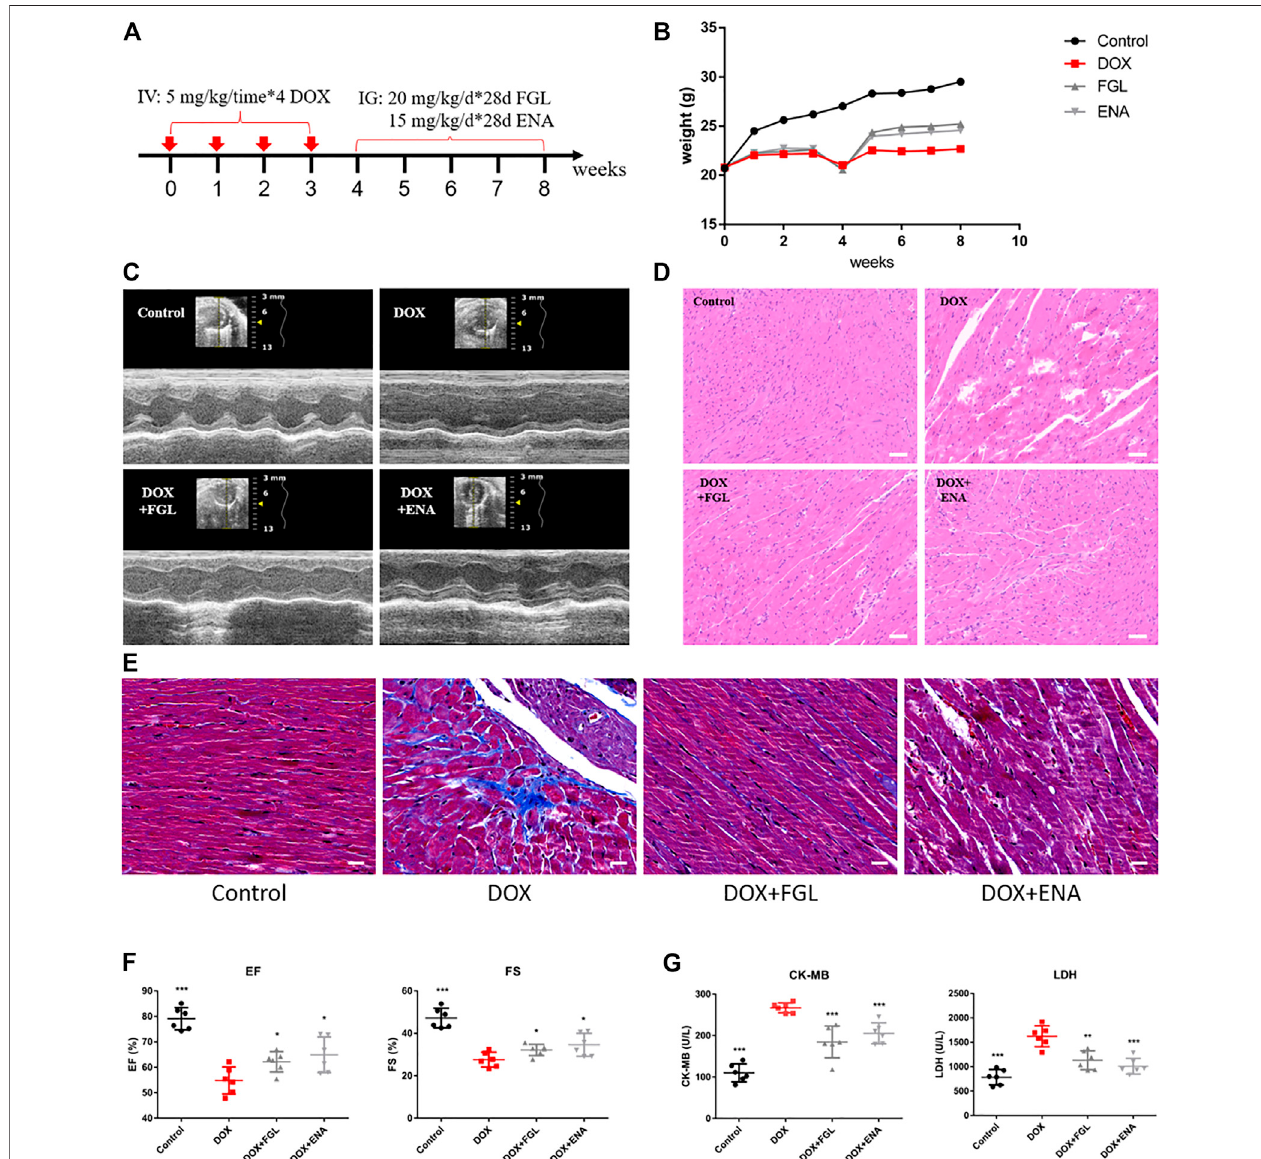
FIGURE 1 | FGL relieved DOX-induced cardiac structural and functional lesion. (A) A schematic diagram of animal model generation and drug administration. (B) Bodyweight changesin various groups (n (cid:2) 10). (C) Representative images ofechocardiograms. (D) Representativeimages ofmorphological and structuralchangesin themyocardium.Scalebar:50 μ m. (E) Myocardial fi brosisdetection byMassonstaining. (F) Theeffects ofFGLandENA onDOX-induced cardiac EFand FS(n (cid:2) 6). (G) The effects of FGL and ENA on cardiac serum CK-MB and LDH (n (cid:2) 6). * p < 0.05, ** p < 0.01, *** p < 0.001 vs DOX group.